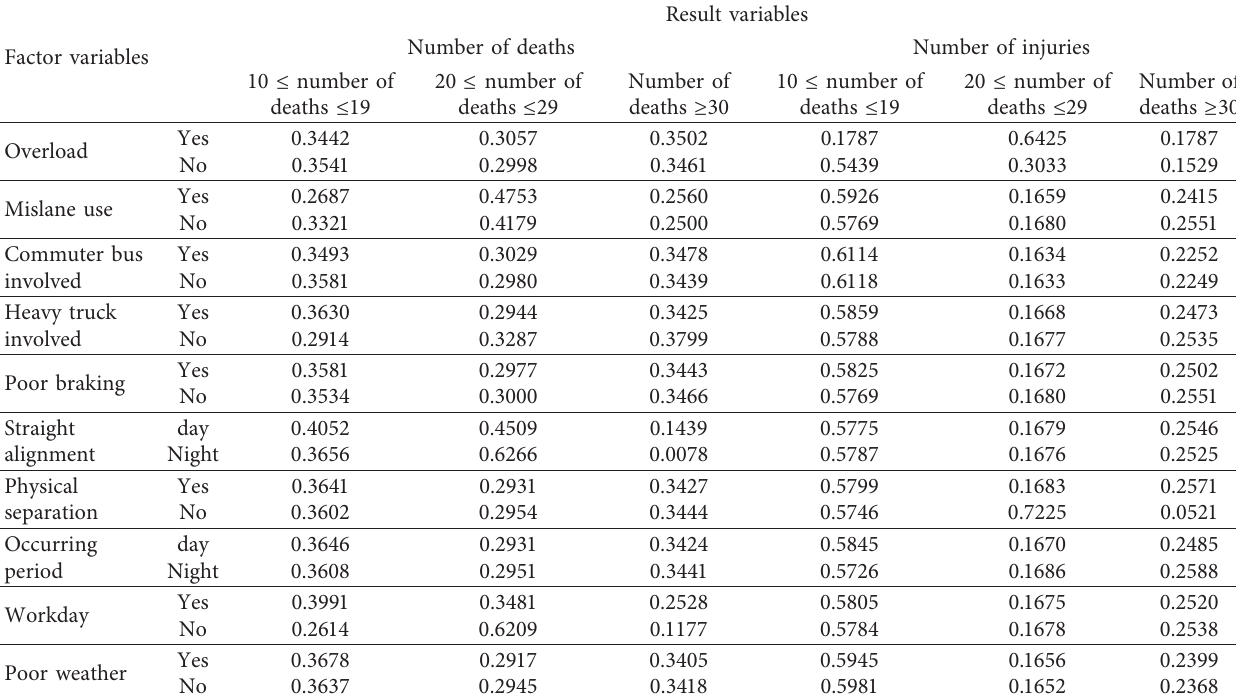
Table 7: The conditional probability of the number of injuries for the single-vehicle traffic